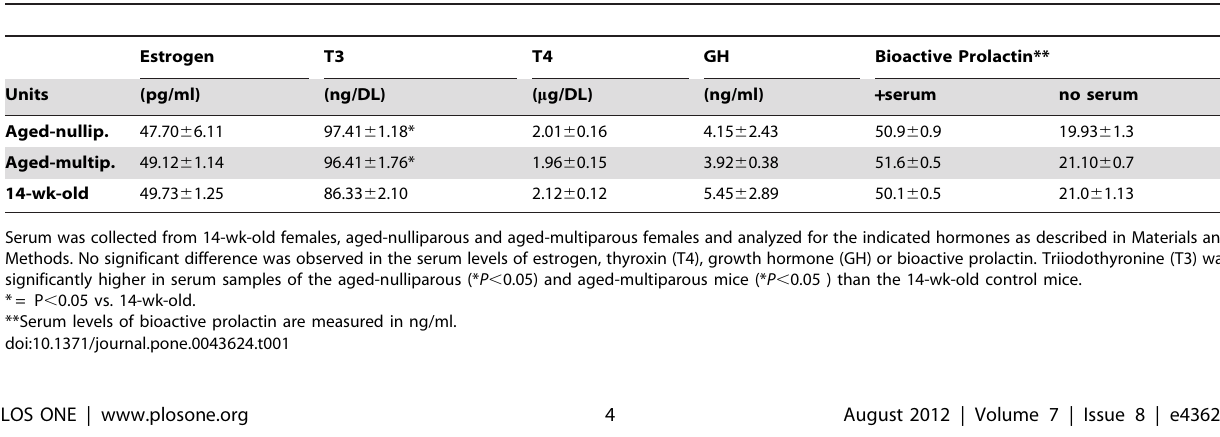
Table 1. Effects of age and parity on serum hormone levels in the FVB/N-RC mice.